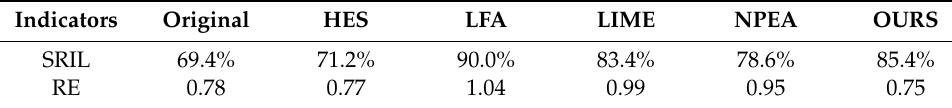
Table 6. Performance indicators in SFM.